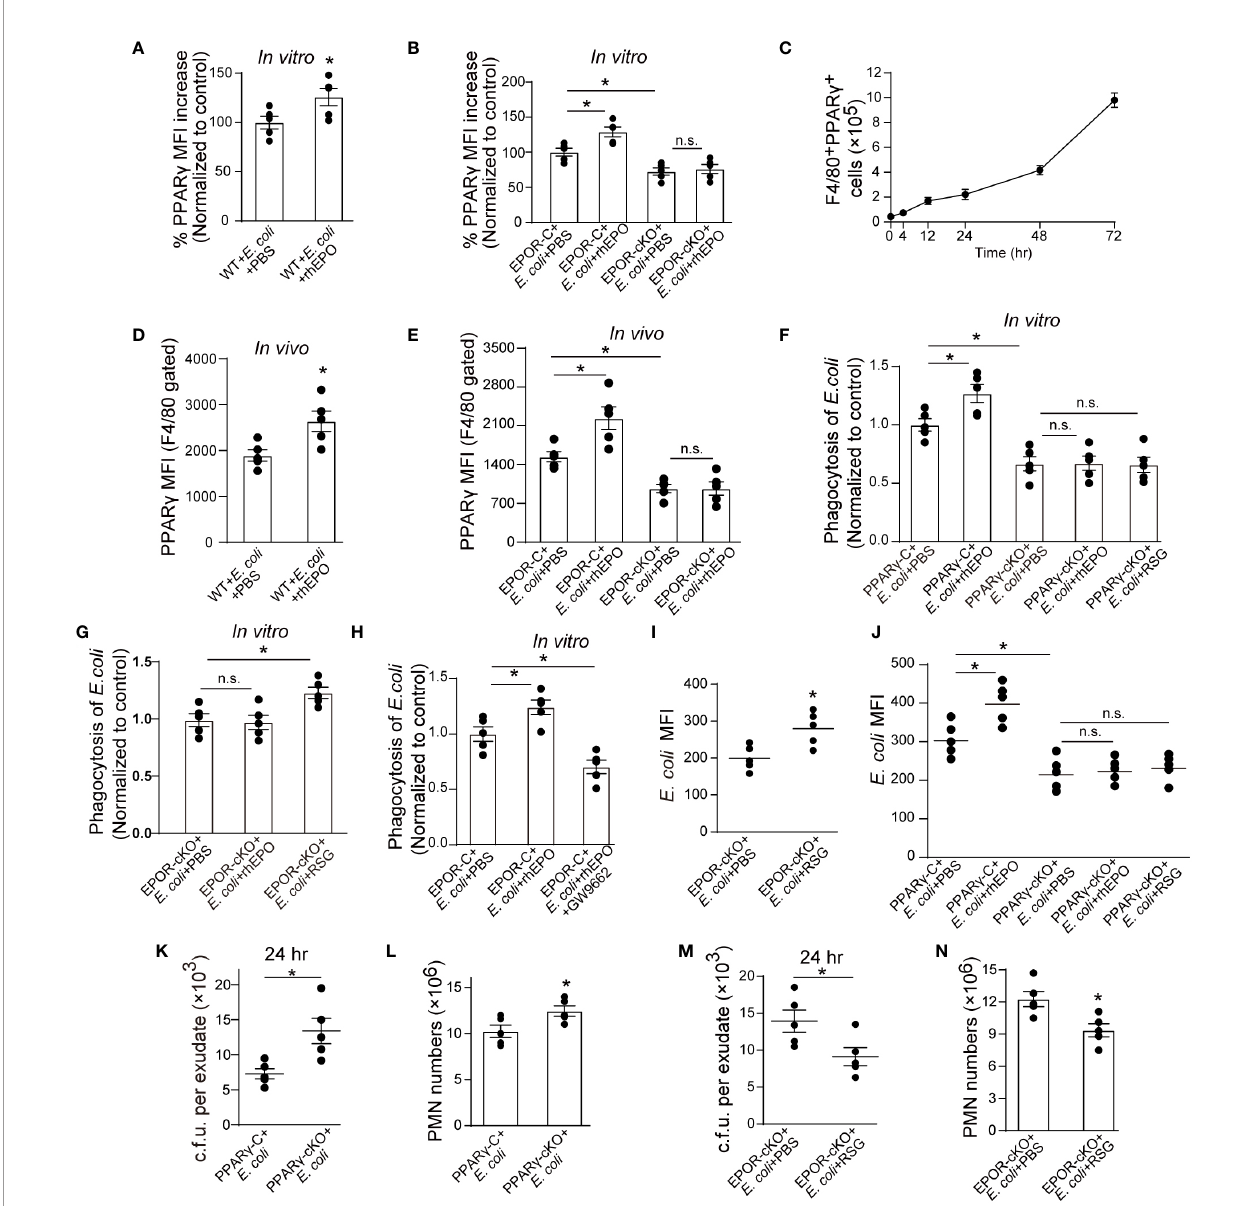
FIGURE 4 | EPO promotes macrophage clearance of E. coli through PPAR g . (A, B) : Thioglycolate-elicited peritoneal macrophages from WT mice (A) or EPOR-cKO mice (B) were stimulated with rhEPO (20 IU/ml) or PBS in presence of heat deactivated E. coli (macrophage: E. coli = 1: 10) for 24 hrs and PPAR g expression was evaluated by fl ow cytometry (n = 5). (C) : WT mice were inoculated with E. coli at 1 × 10 5 c.f.u. and peritoneal exudates of F4/80 + PPAR g + macrophages were assayed by fl ow cytometry at indicated time points (n = 5). (D, E): WT (D) or EPOR-cKO (E) mice were inoculated with E. coli at 1 × 10 5 c.f.u. together with rhEPO (5,000 IU/kg) or PBS for 24 hrs and then peritoneal macrophage PPAR g levels were measured (n = 5). (F – H) : Thioglycolate-elicited peritoneal macrophages were cultured with rhEPO (20 IU/ml, 24 hrs), RSG (10 m M, 48 hrs), GW9662 (10 m M, 48 hrs) or PBS and then incubated with fl uorescently labeled E . coli for 30 min (macrophage: E. coli = 1: 10) for phagocytosis assay (n = 5). (I) : EPOR-cKO mice were pretreated with RSG (10 mg/kg, i.g.) or PBS for 5 days. On day 6, mice were inoculated with E. coli at 1 × 10 5 c.f.u. Intracellular E. coli levels in macrophages were analyzed at 24 hrs (n = 5). (J) : PPAR g -C and PPAR g -cKO mice were inoculated with E. coli at 10 5 c.f.u. together with rhEPO (5,000 IU/kg), RSG (pretreated by 10 mg/kg, i.g. for 5 days) or PBS for 24 hrs. Intracellular E. coli levels in macrophages were analyzed at 24 hrs (n = 5). (K , L) : PPAR g -C and PPAR g -cKO mice were inoculated with E. coli at 1 × 10 5 c.f.u. (n = 5). (M, N) : EPOR-cKO mice were pretreated with RSG (10 mg/kg, i.g.) or PBS for 5 days. On day 6, mice were inoculated with E. coli at 1 × 10 5 c.f.u. (n = 5). E. coli exudates in peritoneal lavage fl uids (K, M) , peritoneal exudates PMN cells (L, N) were assayed at 24 hrs. Data are representative of at least two independent experiments. Results were expressed as mean ± SEM. ns, not statistically signi fi cant. * P < 0.05. Statistics: unpaired two-tailed Student ’ s t-test (A, D, I, K – N) or one-way ANOVA with Tukey ’ s post hoc test for multiple comparisons (B, E – H, J)